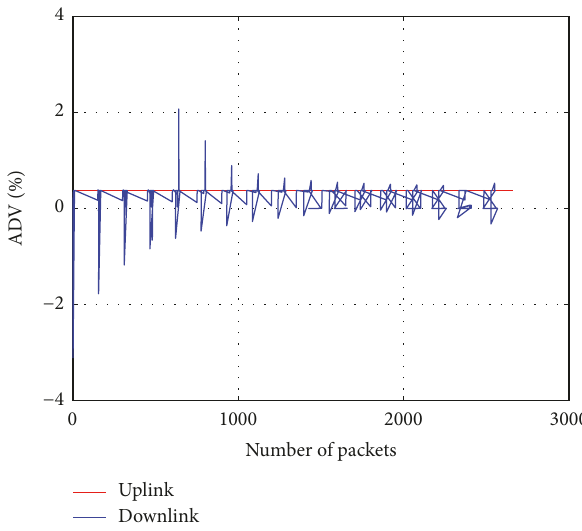
Figure 8: Average delay variance (ADV) comparison between uplink and